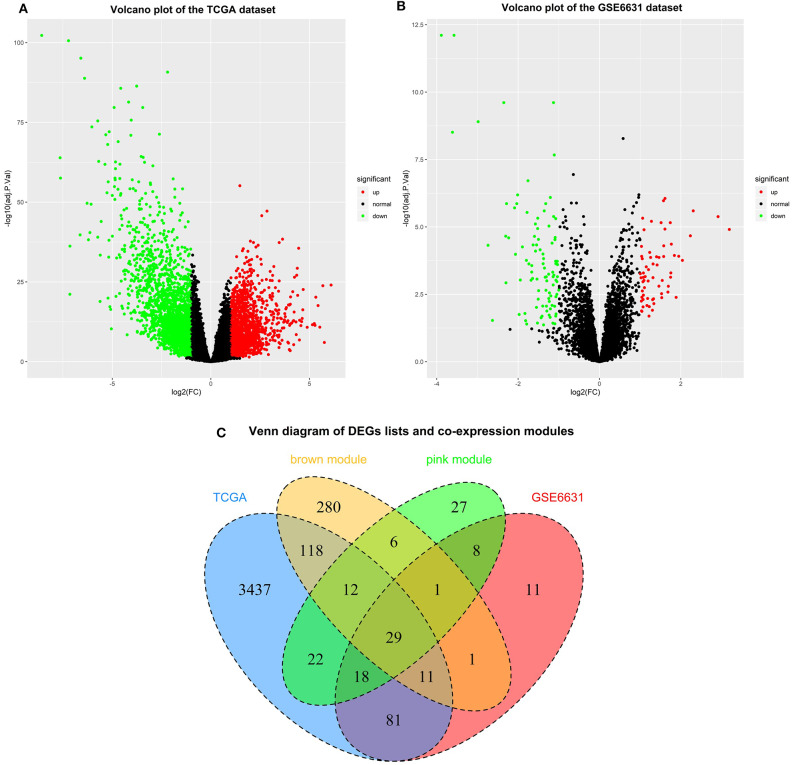
Identification of differentially expressed genes (DEGs) among the TCGA and GSE6631 datasets of HNSCC with the cut-off criteria of |logFC| ≥ 1.0 and adj. P < 0.05. (A) Volcano plot of DEGs in the TCGA dataset. (B) Volcano plot of DEGs in the GSE6631 dataset. (C) The Venn diagram of genes among DEG lists and co-expression module. In total, 29 overlapping genes in the intersection of DEG lists and two co-expression modules.